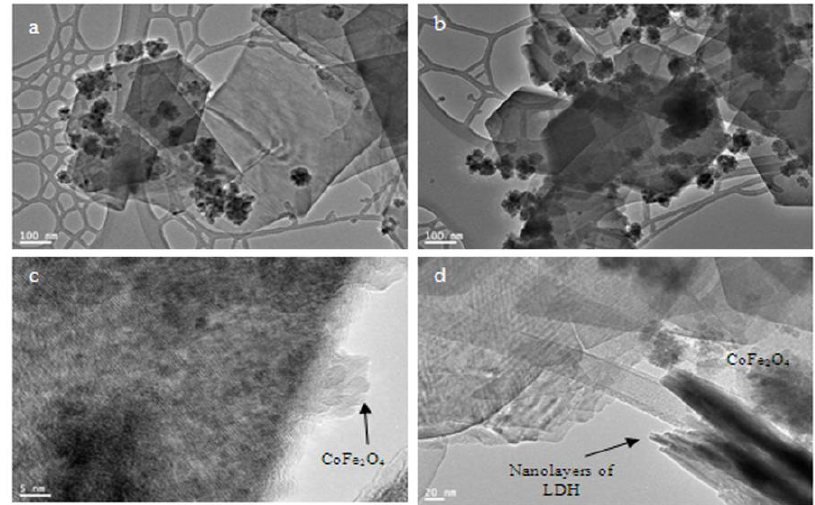
Figure 5. TEM images of the CoFe 2 O 4 -supported Co-Fe LDH.